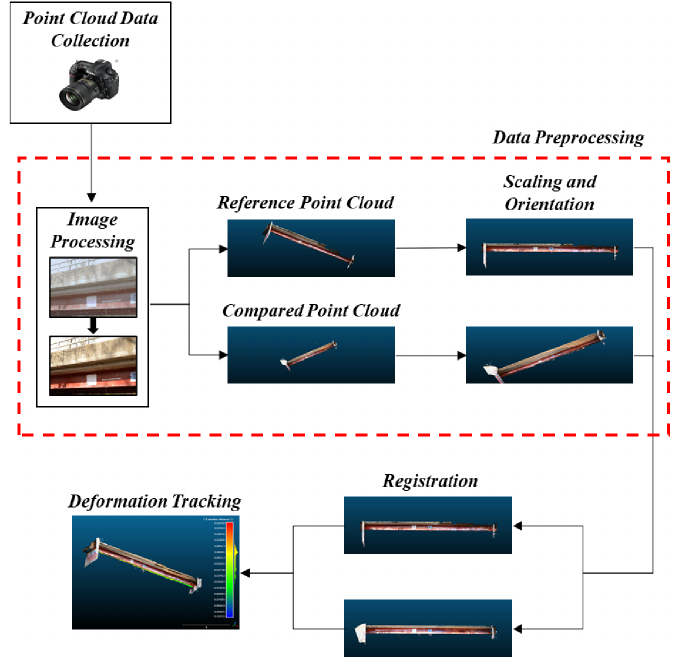
Figure 1. Overview of the